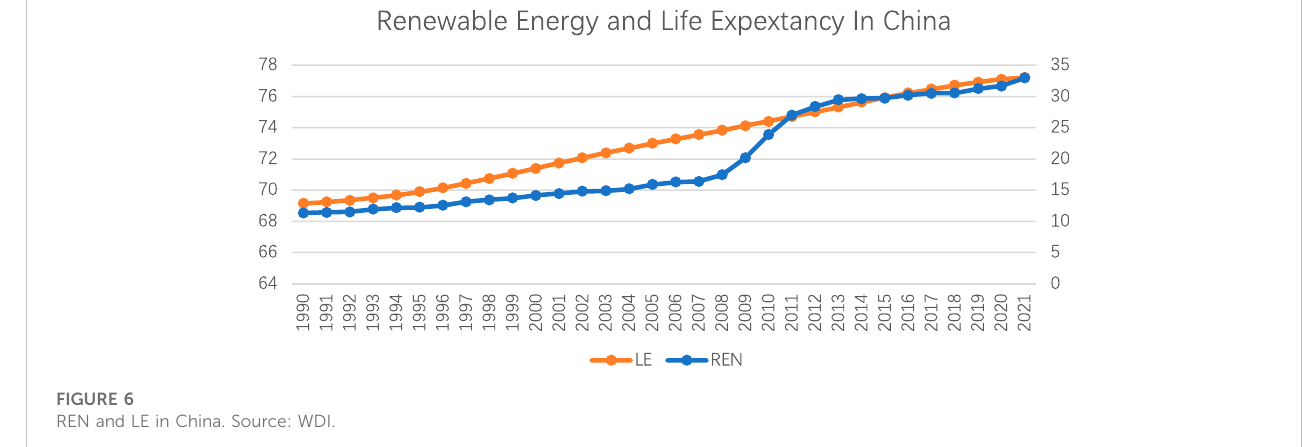
FIGURE 6 REN and LE in China. Source: